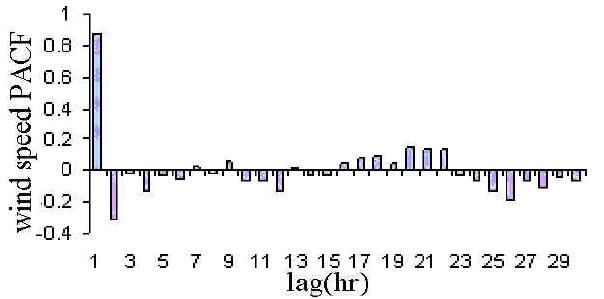
Figure12. Significant wave height auto correlation with 1hr time lag